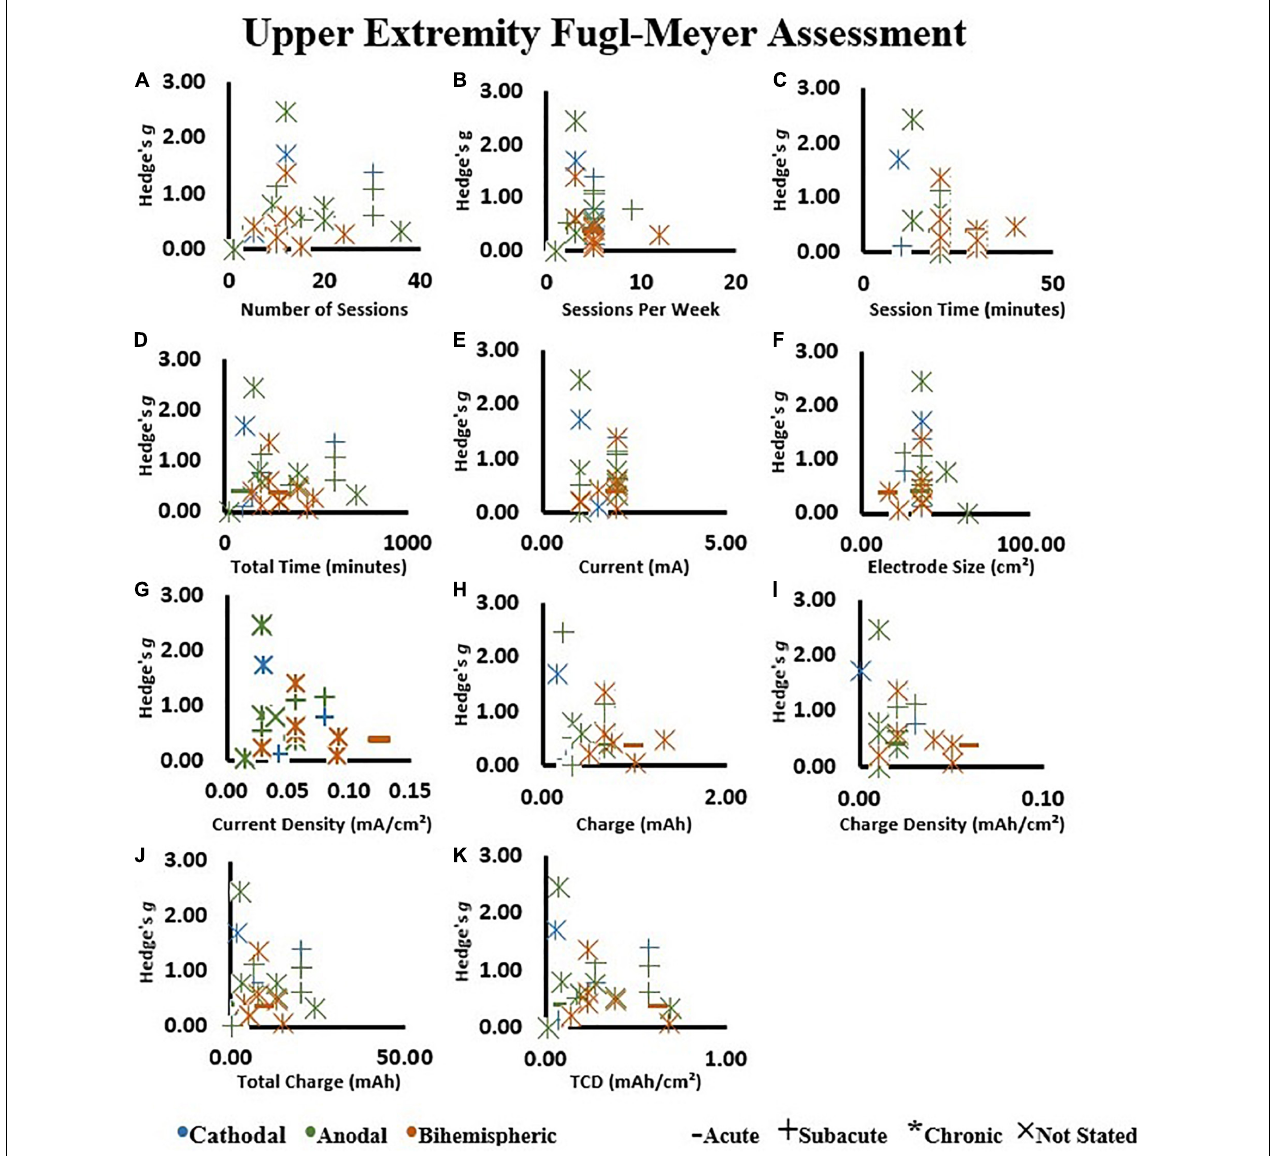
FIGURE 8 | Effect size in the tDCS groups assessed by the upper extremity Fugl–Meyer Assessment relative to: (A) Number of sessions, (B) sessions per week, (C) session time, (D) total tDCS application time, (E) current, (F) electrode size, (G) current density, (H) charge, (I) charge density, (J) total charge, and (K) total charge density (TCD). An increase in Hedge’s g effect size indicates a better